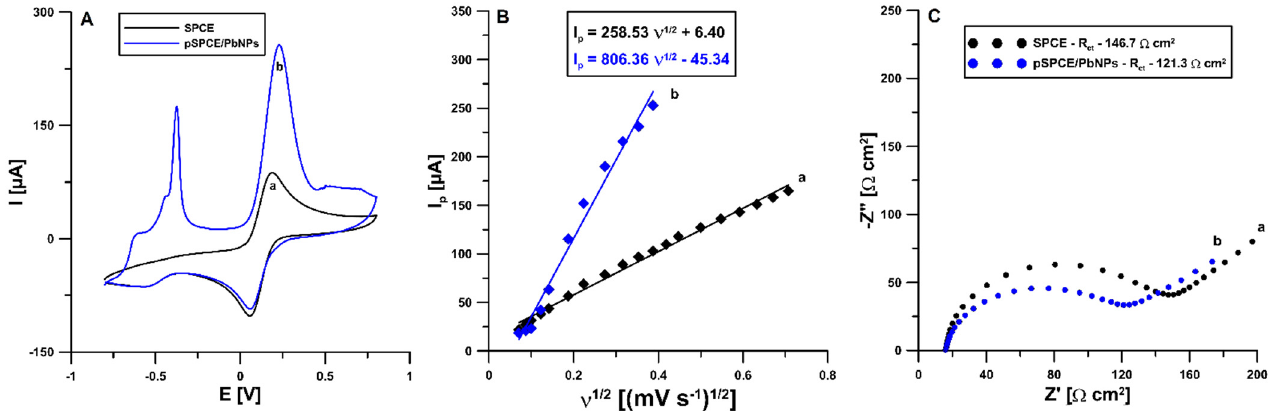
Figure 3. ( A ) Cyclic voltammograms recorded at the SPCE ( a ) and pSPCE/PbNPs ( b ) using the scan rate of 100 mV s − 1 ; ( B ) the relationship between the anodic peak current (I p ) and the square root of the scan rate ( υ 1/2 ) obtained at the SPCE ( a ) and pSPCE/PbNPs using the scan rate from 5 to 150 mV s − 1 ; ( C ) Nyquist plots of the SPCE ( a ) and pSPCE/PbNPs ( b ) registered at a potential of 0.2 V, in the frequency range from 50 kHz to 1 Hz. All results were performed in 0.1 mol L − 1 KCl and 5.0 mmol L − 1 K 3 (Fe(CN) 6 ).